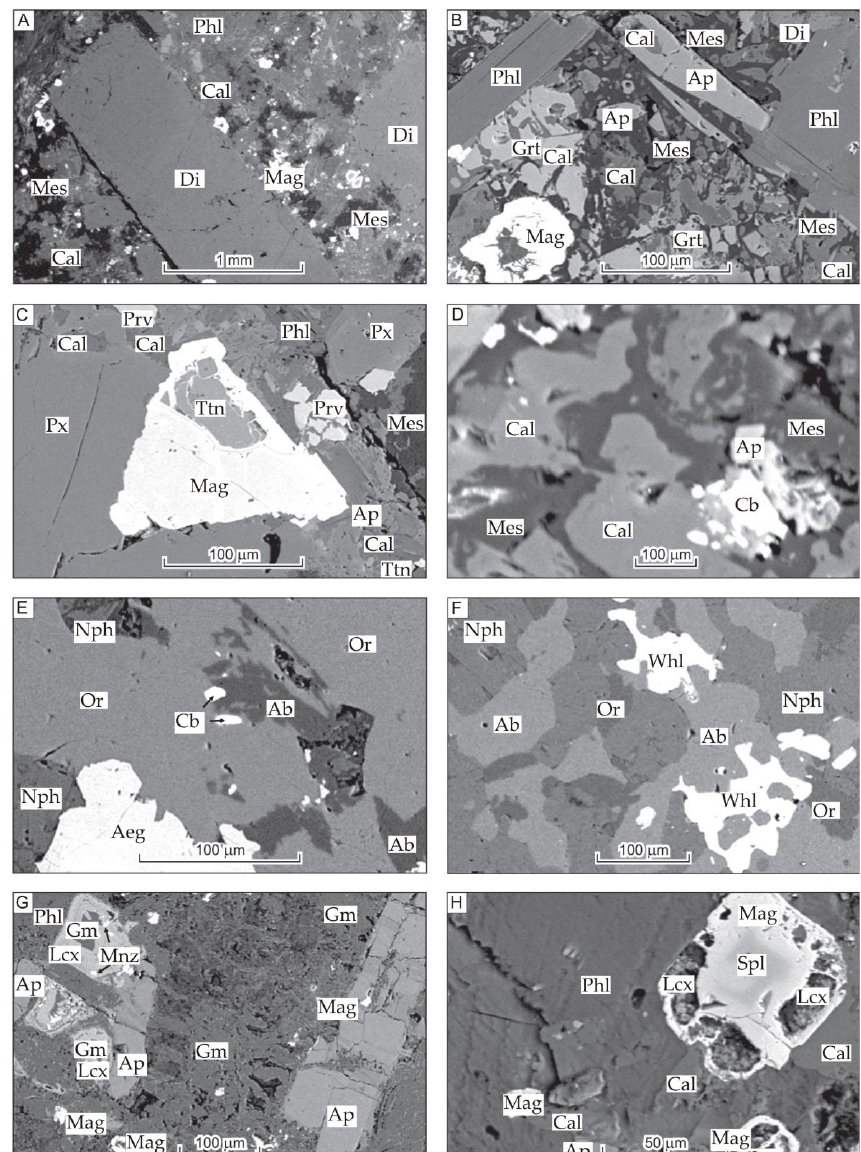
Figure 3. Rock-forming and ore minerals from rocks of Tomtor massif. ( A – D )—melteigites (samp. To-1-2): ( A )—porphyry of diopside (Di) in the groundmass of phlogopite (Phl), calcite (Cal), mesolite (Mes) and magnetite (Mag); ( B )—porphyry crystals of phlogopite (Phl) in grained groundmass that contained diopside (Di), calcite (Cal), mesolite (Mes), magnetite (Mag), garnet (Grt) and apatite (Ap); ( C )—intergrowth of pyroxene (Px), magnetite (Mag), titanite (Ttn) and perovskite (Prv), surrounded by phlogopite (Phl)–calcite (Cal)–mesolite (Mes) groundmass; ( D )—small particles of REE carbonates (Cb) in association with apatite (Ap) in calcite (Cal)–mesolite (Mes) symplectite mass: ( E , F )—nepheline syenites (samp. To-3-1): ( E )—small inclusions of REE carbonates (Cb) in albite (Ab)–orthoclase (Or) micro perthite in concrescence with nepheline (Nph) and aegirine (Aeg); ( F )—“amoeba-shaped” inclusions of wohlerite (Whl) in nepheline (Nph)–albite (Ab)–orthoclase (Or) symplectite matrix; ( G , H )—carbonatites (samp. To-5-1): ( G )—euhedral crystals of apatites (Ap) and “case-shaped” zoned substance of leucoxene (Lcx) with small inclusions Ce–monazite (Mnz) in clay–siderite–calcite (Gm) groundmass; ( H )—zoned grain magnetite (Mag) with a relict core of chromium spinellid (Spl) in intergrowth with phlogopite (Phl) and calcite (Cal). Image in back-scattered